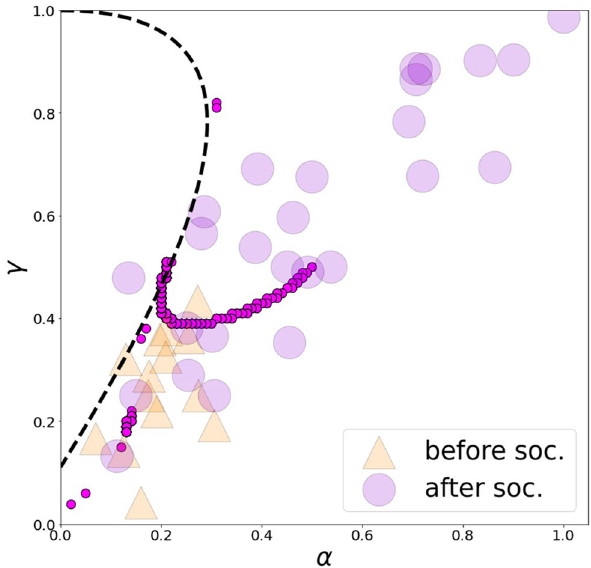
Figure 5. The dashed line represents the Nash equilibrium. The pink circles represent the QRE curve. The orange triangles signify participants’ strategies before socialization, while the violet circles signify participants’ strategies after socialization. The QRE for PD in Markov strategies points for (cid:31) < ∼ 5 serve as a natural border between points before and after